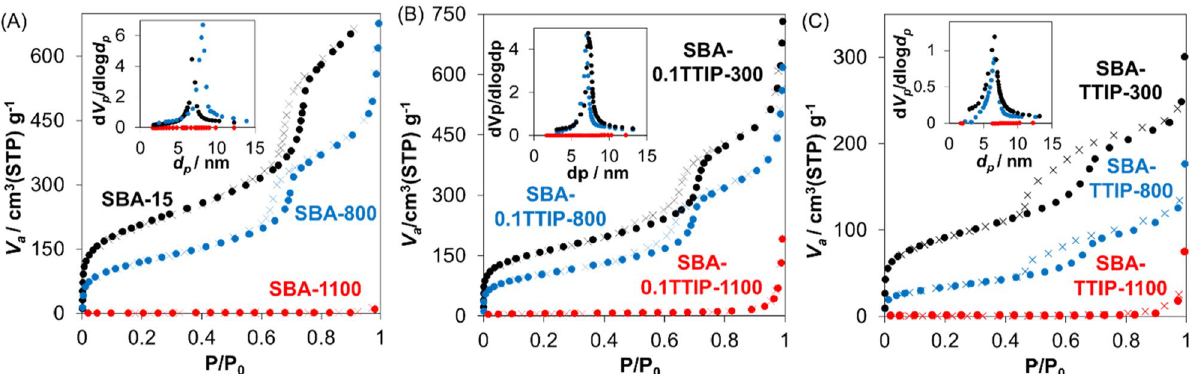
Figure 2. N 2 adsorption (•)/desorption (x) isotherms and the BJH pore-size distribution (insets) of ( A ) SBA-15, ( B ) SBA-0.1TTIPs and ( C ) SBA-TTIPs before and after the heat treatment at the temperature given in the